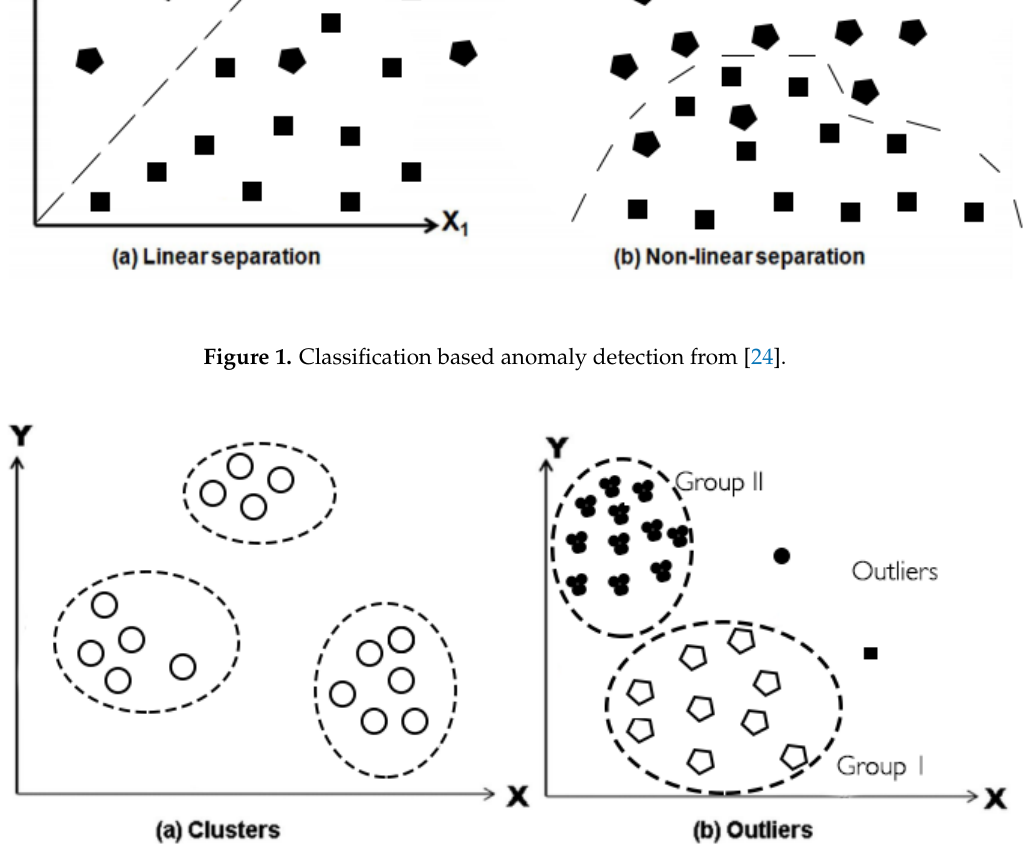
Figure 2. Clustering and outlier based anomaly detection